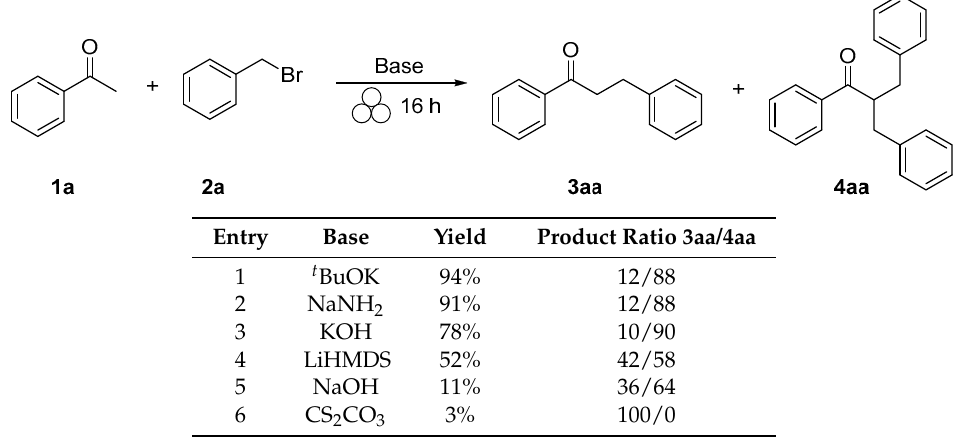
Table 1. Comparison of bases in enolate reactivity.